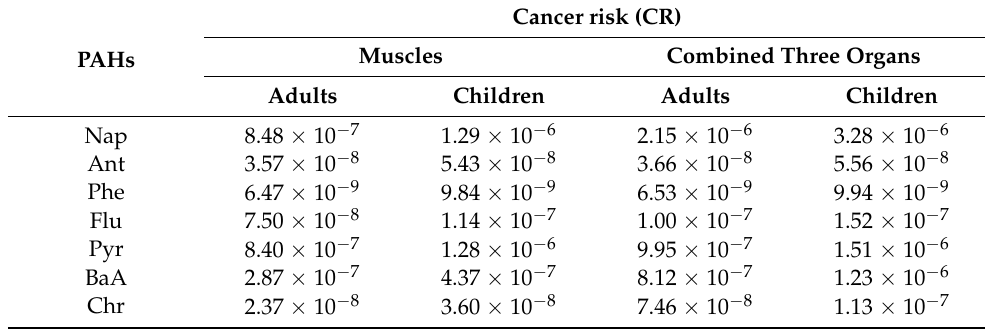
Table 6. The cancer risk (CR) for carcinogenic effect.